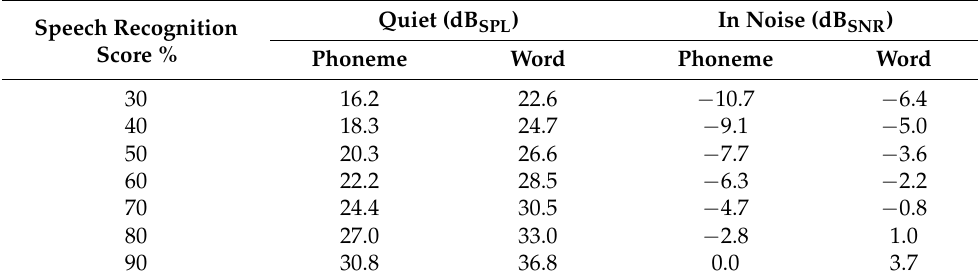
Table 1. Sound levels for different speech recognition scores in quiet and in noise (phoneme and word scoring).